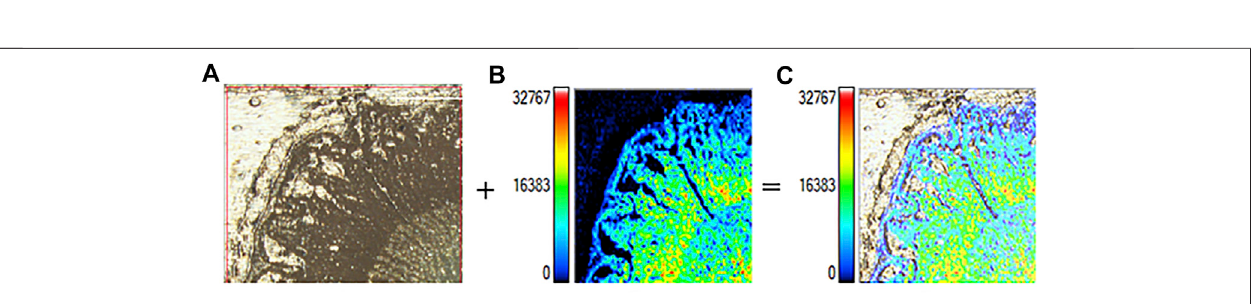
Frontiers in Pharmacology |